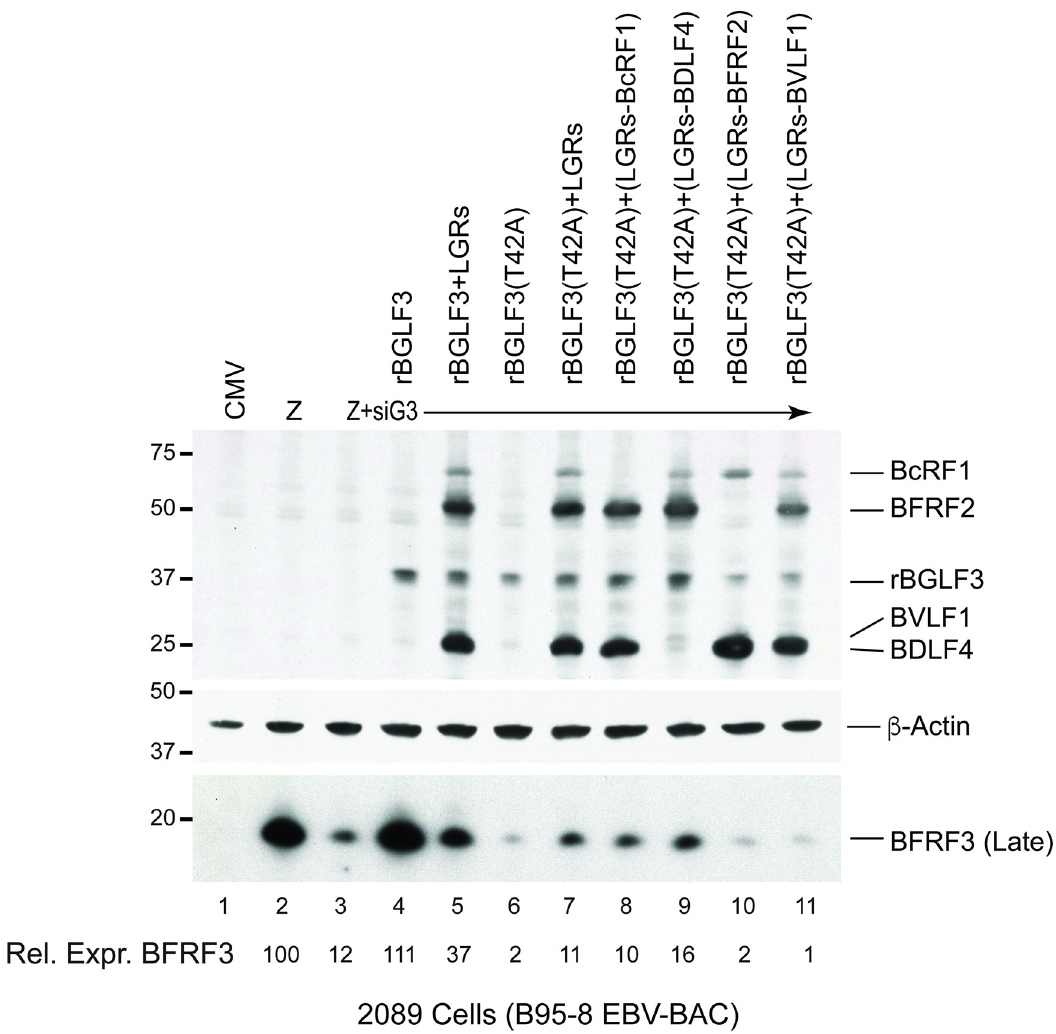
Fig 6. Elimination of BFRF2 or BVLF1 abolishes the capacity of vPIC to suppress the late gene expression defect of BGLF3 (T42A). Western blot analysis of 2089 cells transfected with empty vector (CMV), ZEBRA (Z), and ZEBRA plus siBGLF3 (siG3). Knockdown of endogenous BGLF3 was complemented with siBGLF3-resistant wild type BGLF3 (rBGLF3) or mutant protein [rBGLF3(T42A)]. Failure of BGLF3(T42A) to activate expression of the late BFRF3 protein was partially overcome by expressing a mixture of four vPIC proteins (BcRF1, BDLF4, BFRF2, and BVLF1). Components of vPIC were individually omitted from the complex to assess the role each late gene regulator plays in suppressing the phenotype of BGLF3(T42A). The membrane was blotted with antibodies specific to β -actin (gel loading control), late BFRF3 and FLAG epitope for detection of late gene regulators. The experiment is a representative of two biological